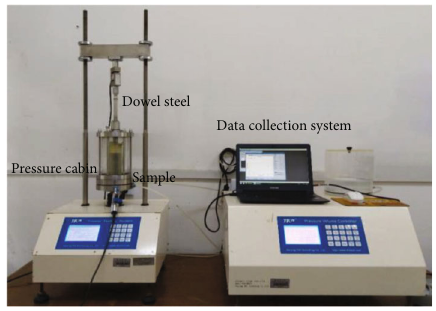
Figure 2: Automatic triaxial apparatus